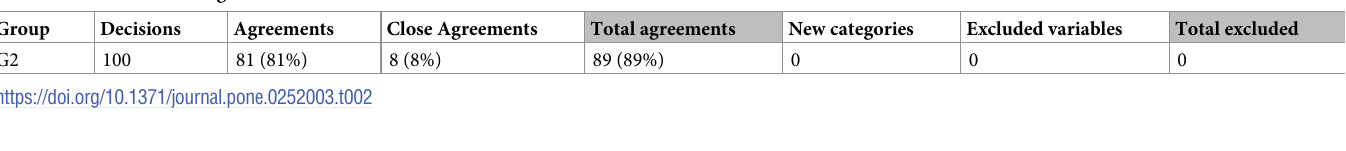
Table 2. Final evaluation agreement